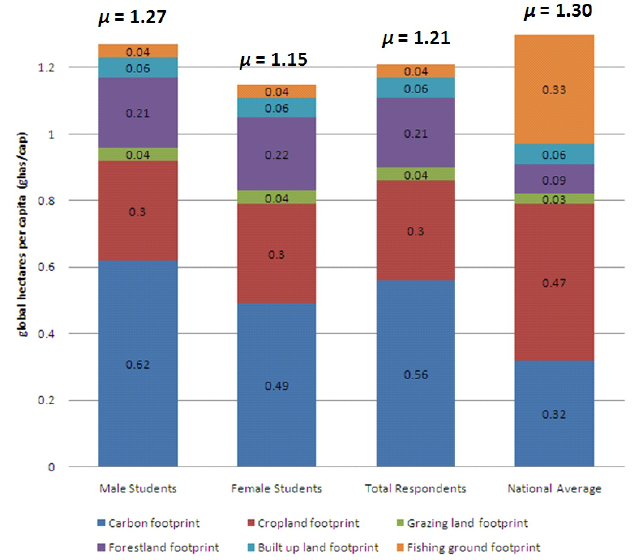
Fig.1: Average per capita EF land use components of respondents compared with the national average in global ha. per capita